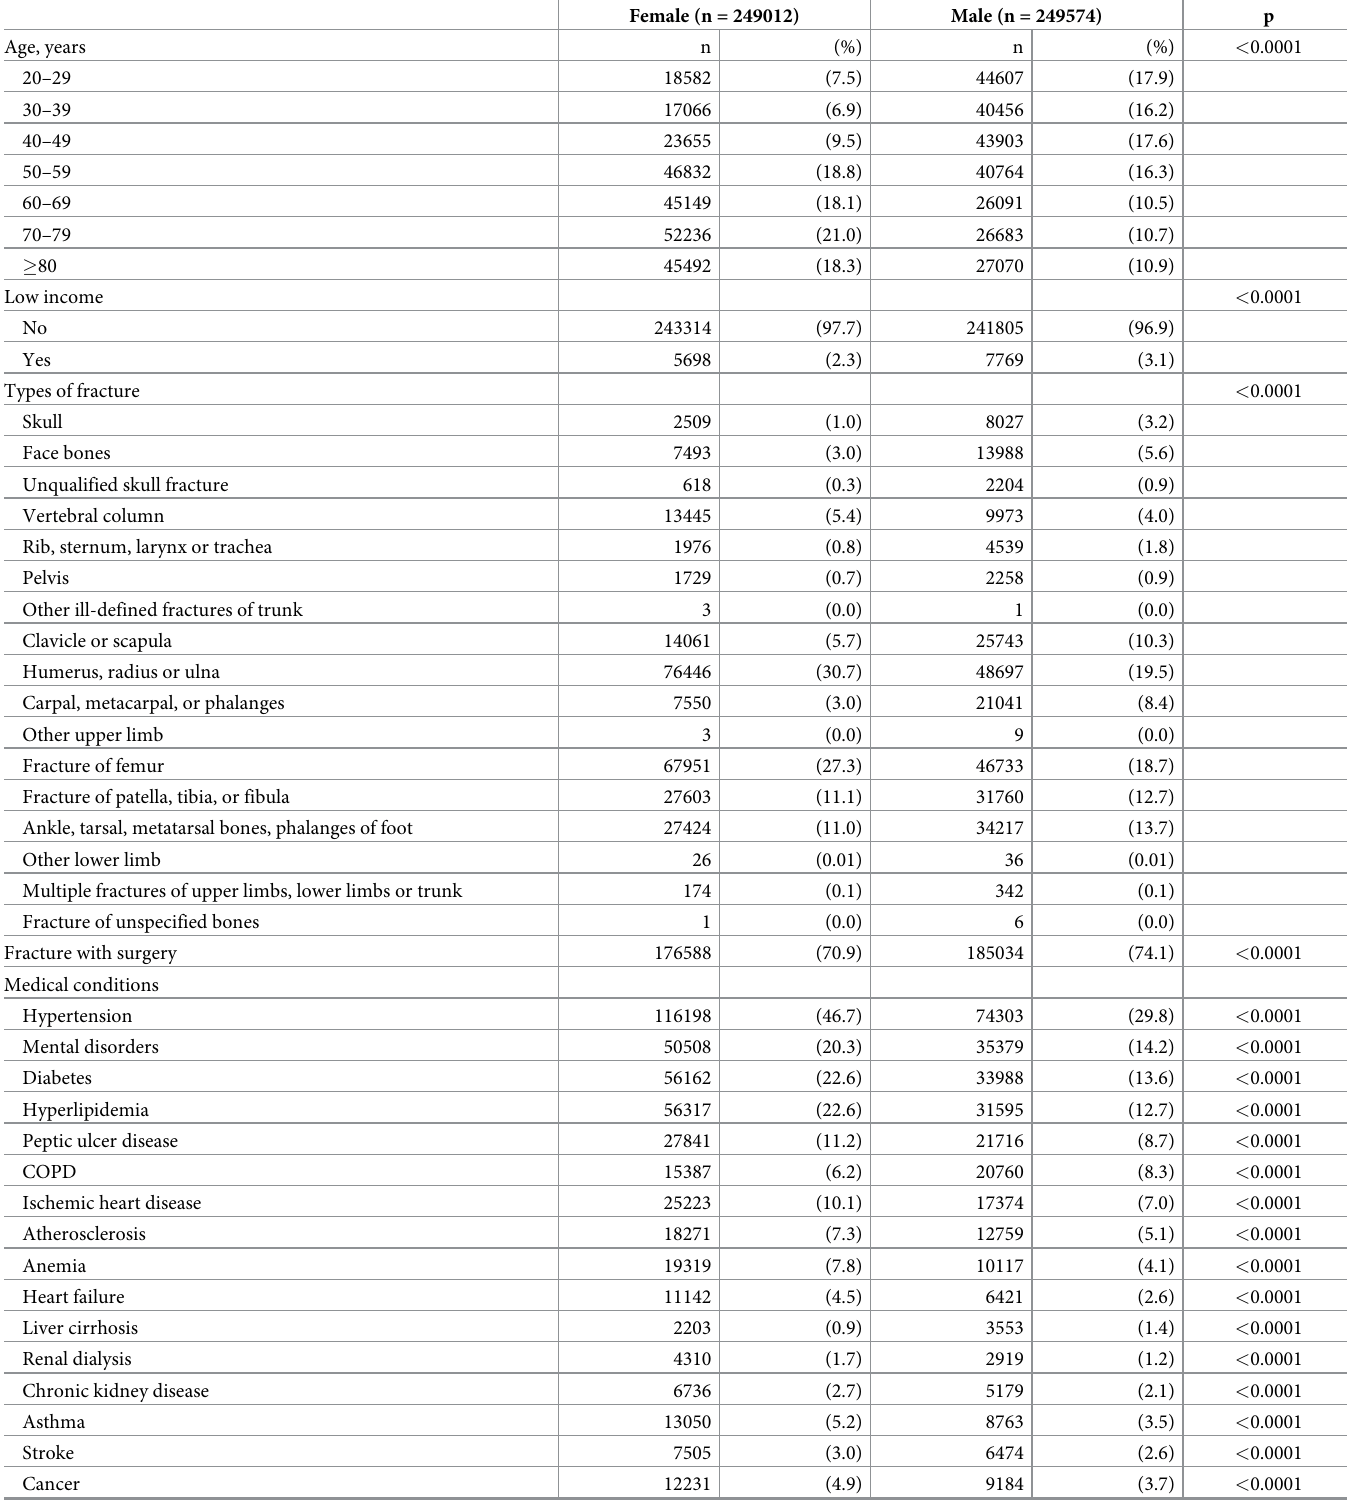
Table 1. Baseline characteristics in female and male fracture patients before